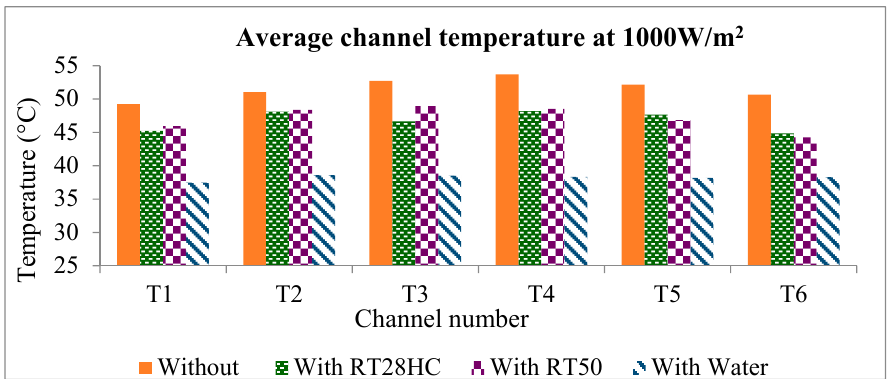
Figure 7. Comparison of average channel temperature, Ti (where i is the channel number) without and with cooling. Table 3. Average temperature reduction in channels with different passive cooling compared with natural ventilation.